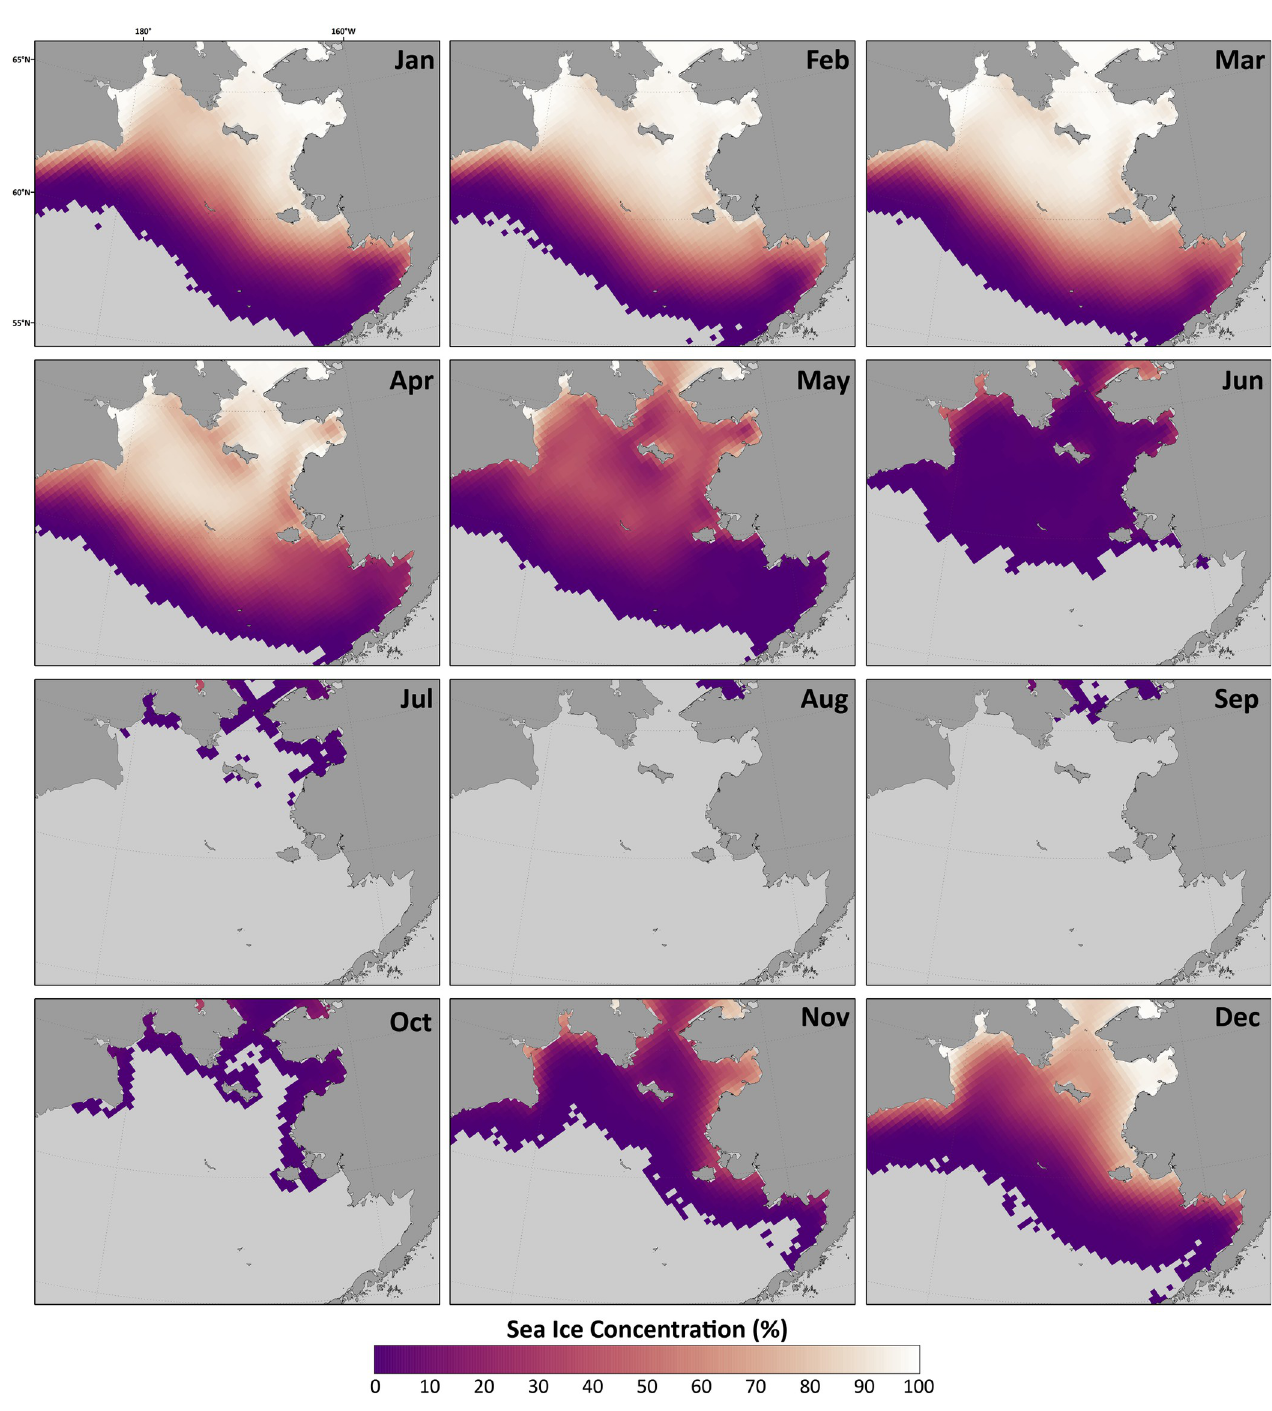
Fig 6. Mean monthly sea ice concentration (1980–2018). Mean sea ice concentration from the Scanning Multi-channel Microwave Radiometer (SMMR), Special Sensor Microwave/Imager (SSM/I), and Special Sensor Microwave Imager/Sounder (SSMIS) passive microwave instruments, calculated using the Goddard Bootstrap (SB2) algorithm [35, 36]. Figure created using Matlab (v. 2018a) from the authors’ data.